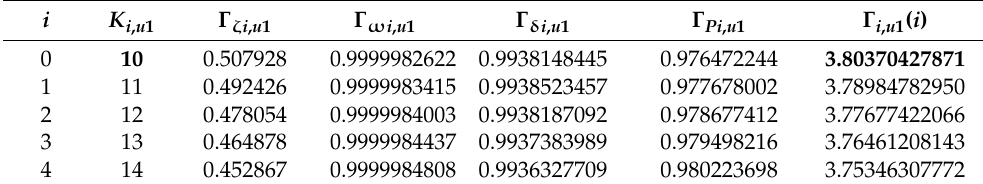
Table 8. Weight functions for PSS parameters T = 0.5 s, K i,um = 10–14, m = 1 ( upper cluster 1 ); t = 30 ms.